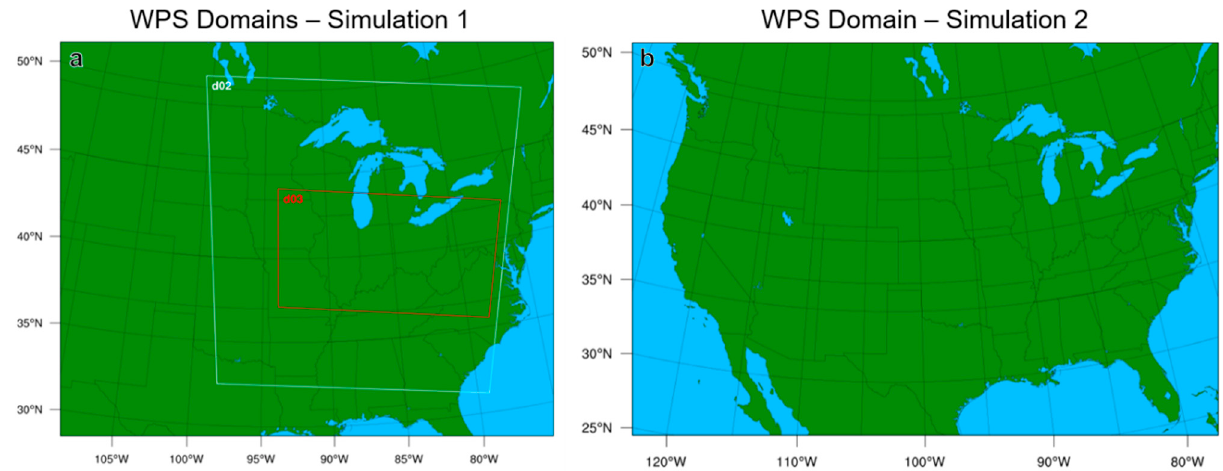
Figure 2. Plot showing the WRF-ARW domains for ( a ) Simulation 1 and ( b ) Simulation 2. On panel ( a ), for Simulation 1, the innermost red polygon labeled “d03” identifies the area covered by domain three, the 2 km simulation. The larger white polygon labeled “d02” shows the area covered by domain two, the 6 km simulation, and the largest, outer map represents area covered by domain one, the 18 km